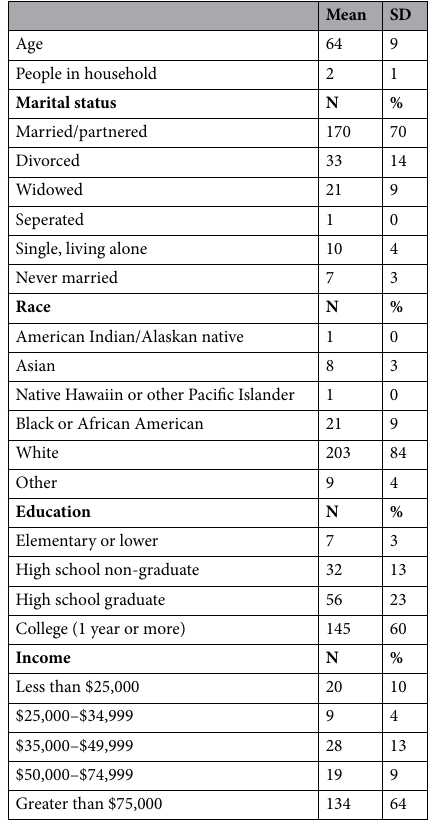
Table 2. Baseline demographic characteristics of study participants.